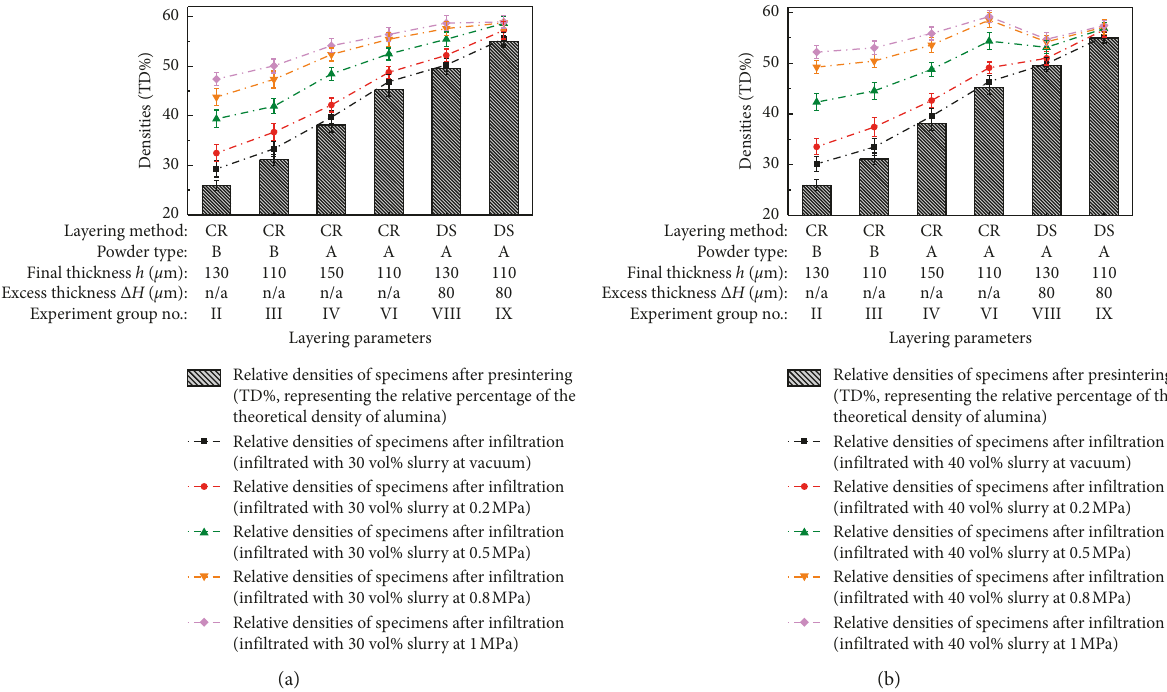
Figure 16: Density increment of the specimens by various infiltration parameters (including different solid loads in slurries and different infiltration pressures). (a) Infiltrating with 30 vol% solid-load slurry. (b) Infiltrating with 40 vol% solid-load